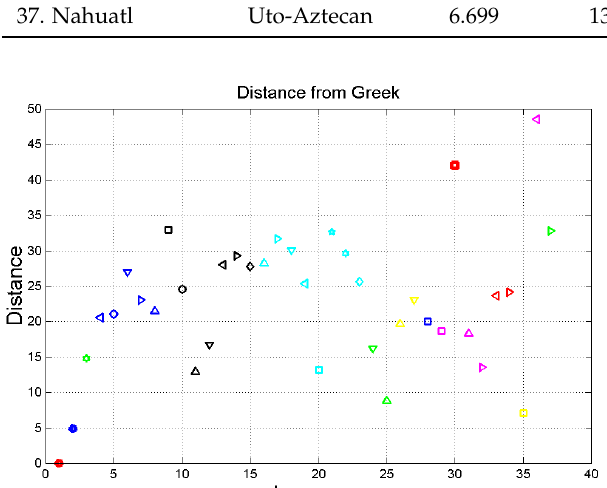
Figure 2. ( Left panel ): Vector plane 𝑥 (cid:3019) and 𝑦 (cid:3019) of all languages concerning Matthew; for Greek 𝑥